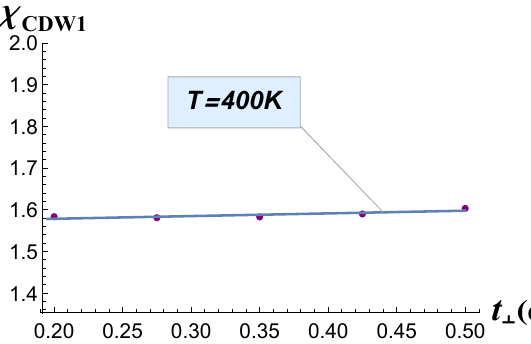
Figure 5. Electron susceptibility χ calculated at T = 400 K as a function of the electron hopping term t ⊥ .